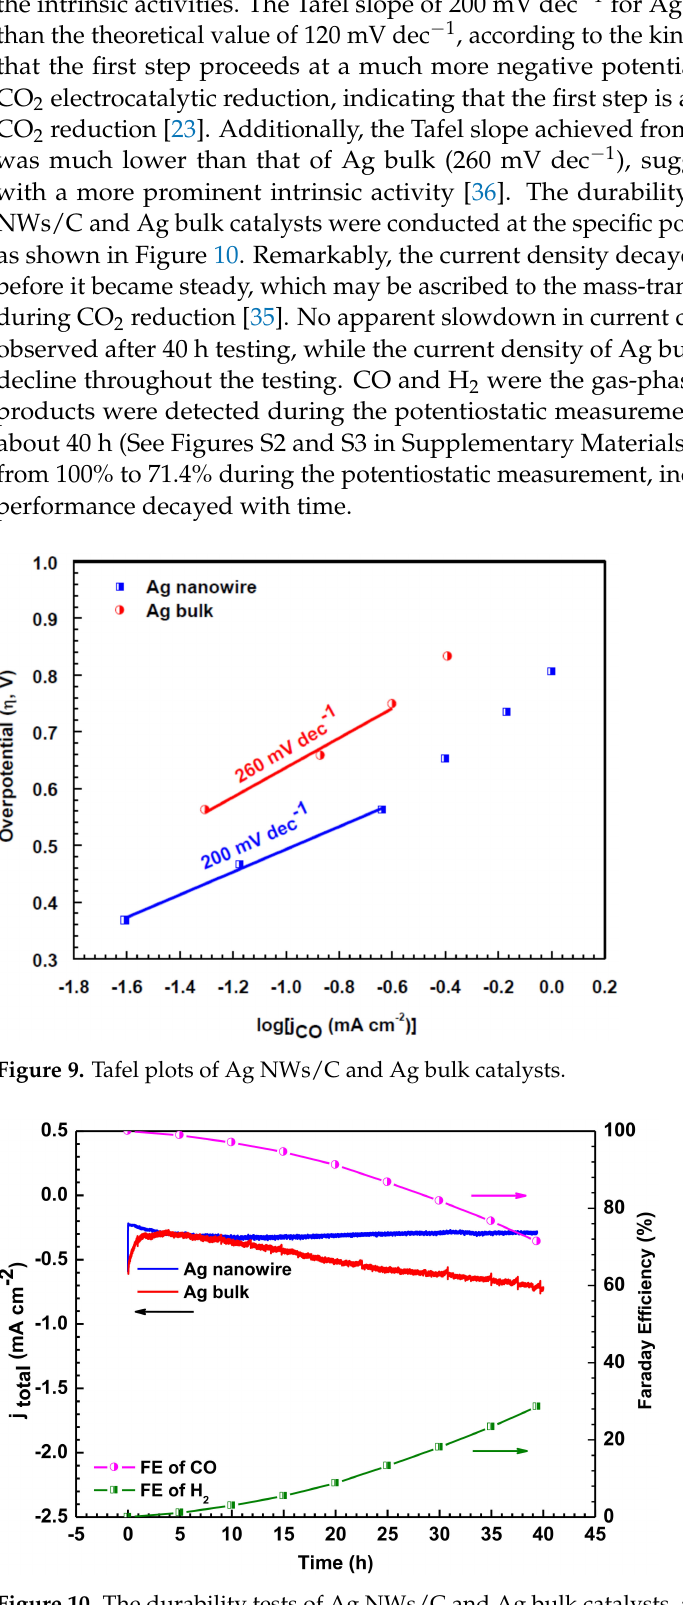
Figure 10. The durability tests of Ag NWs/C and Ag bulk catalysts, and the variation of FE of CO and H 2 with time on Ag NWs/C-modified